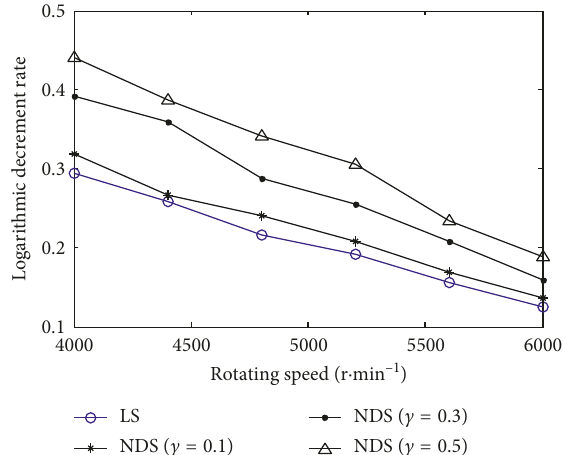
Figure 13: Influence of inlet/out pressure ratios on logarithmic decrement